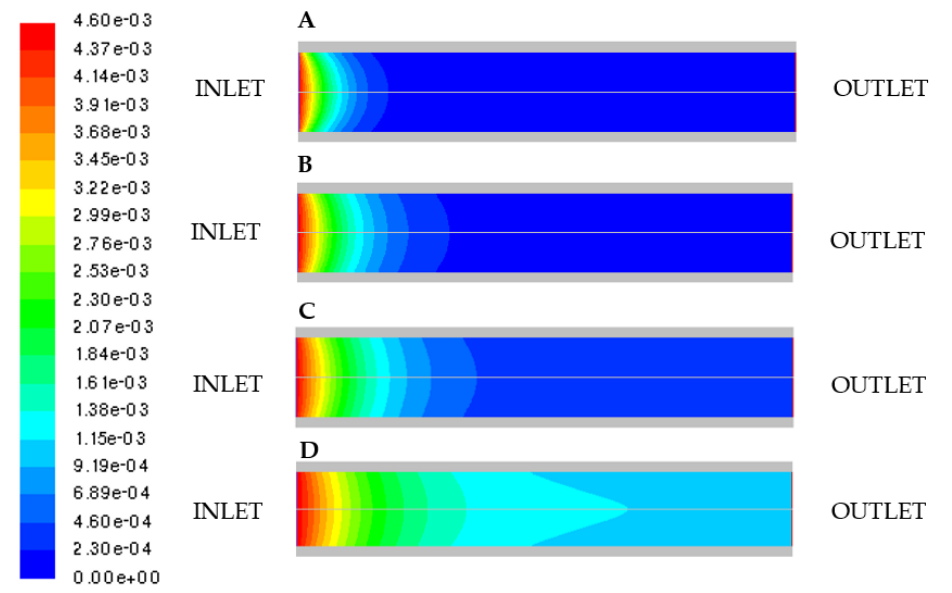
Figure 6. Molar concentration of cellobiose by varying the adsorbed enzyme mass: ( A ) SF = 0.5; ( B ) SF = 0.15; ( C ) SF = 0.075; ( D ) SF = 0.0375.